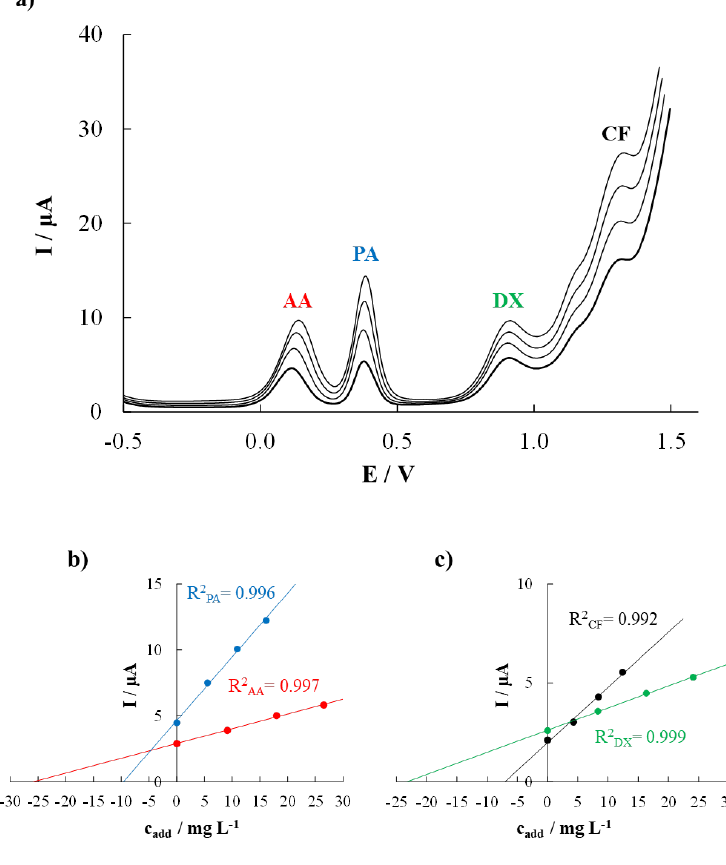
Figure 4. ( a ) DPV measurements in a well water sample in 0.1 mol L −1 acetic/acetate buffer pH 5.00 on SPCE; ( b ) ascorbic acid and paracetamol standard addition plots and ( c ) dextromethorphan and caffeine standard addition plots. Table 3. Determination of target analytes in Frenadol ® Complex drug and in spiked well water by DPV on SPCE by standard addition calibration method.